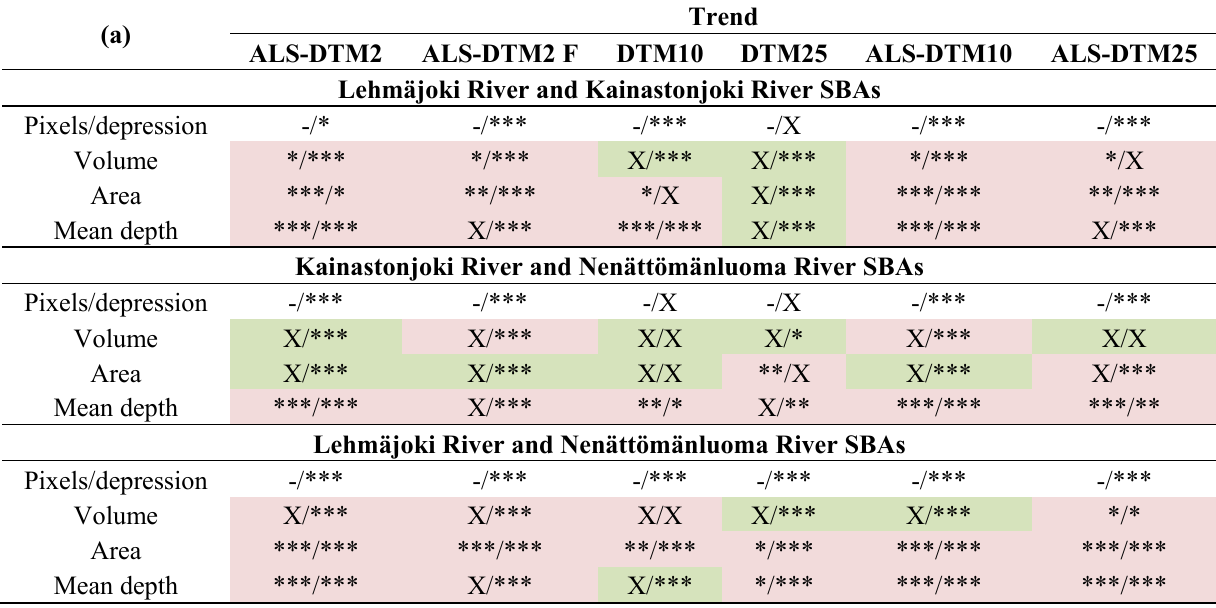
Table 8. The statistical similarity (X) and difference (*) of the distributions of depression variables ( a ) between SBAs and ( b ) within SBAs, when the Kolmogorov-Smirnov test, Levene’s test, independent samples t -test and Mann-Whitney U test were used (See